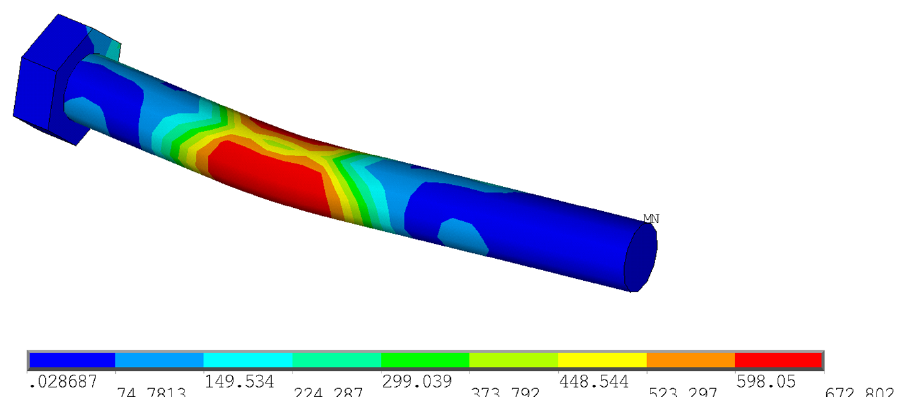
Figure 25. Von Mises stress in the bolt from the numerical analysis.